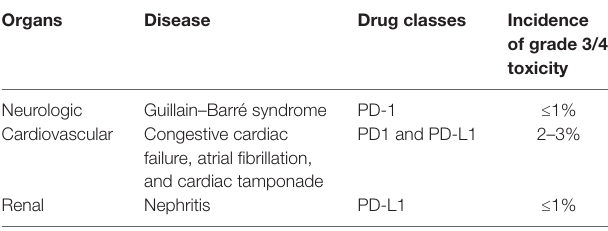
TABLE 3 | List of uncommon iRAEs of ICIs in HNSCC